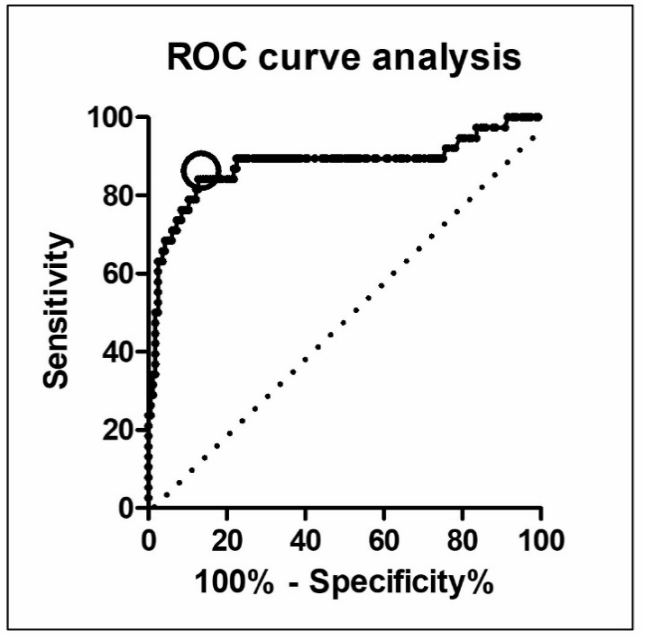
Figure 2. Optimal cut-off value selection for C-reactive protein-to-albumin ratio using receiver operating characteristic curve analysis.